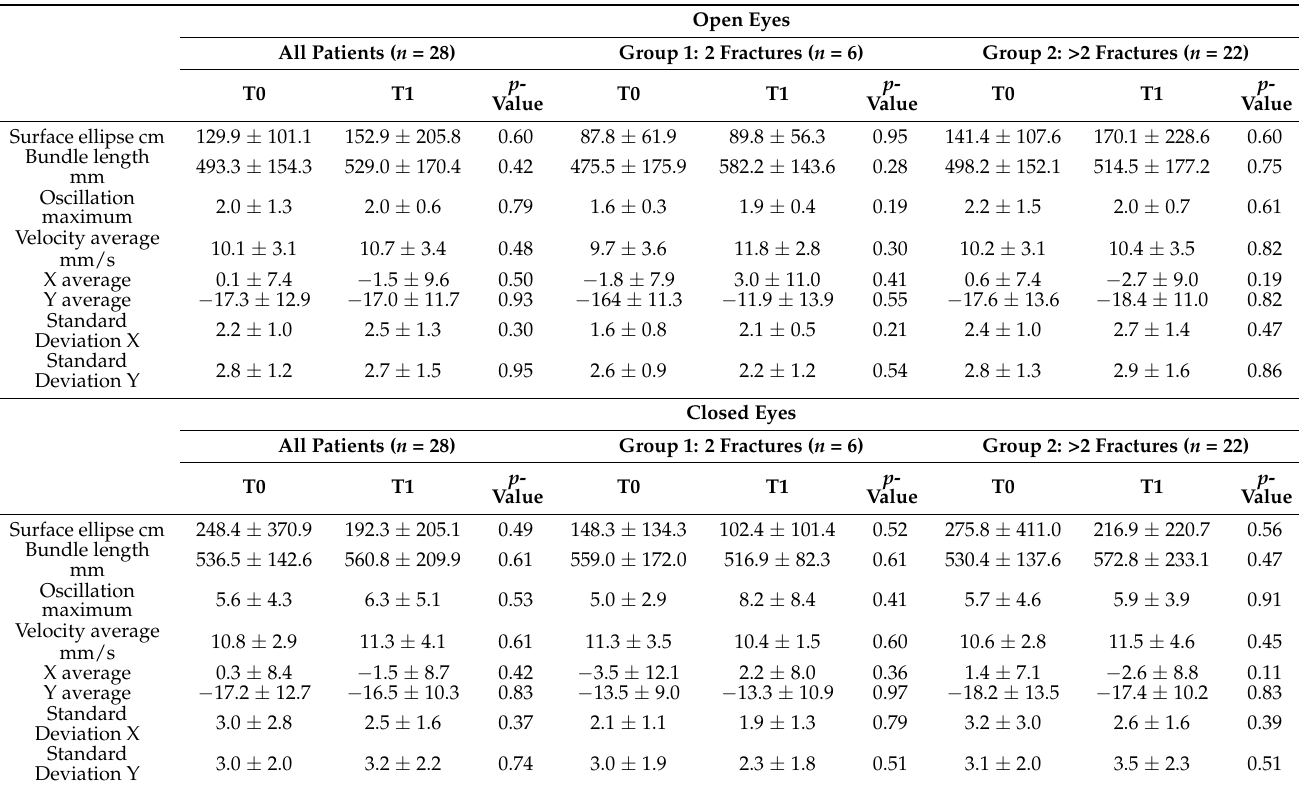
Table 3. Stabilometric